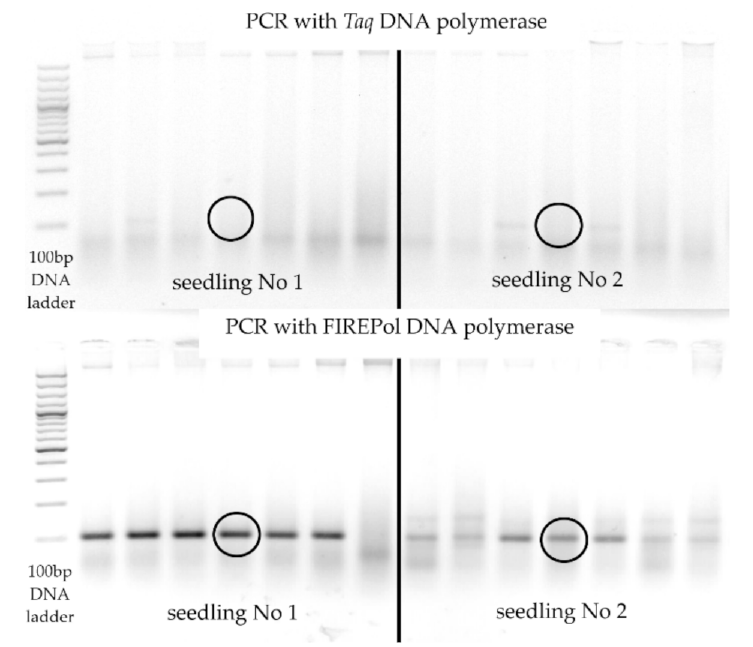
Figure 3. Comparison of the sensitivity of Taq and FIREPol DNA polymerases in detecting H. annosum in DNA extracted from stem discs of two seedlings. Circles indicate DNA samples from stem discs at the inoculation points, lanes to the left and right contain PCR products from DNA samples extracted from discs below and above the inoculation point,